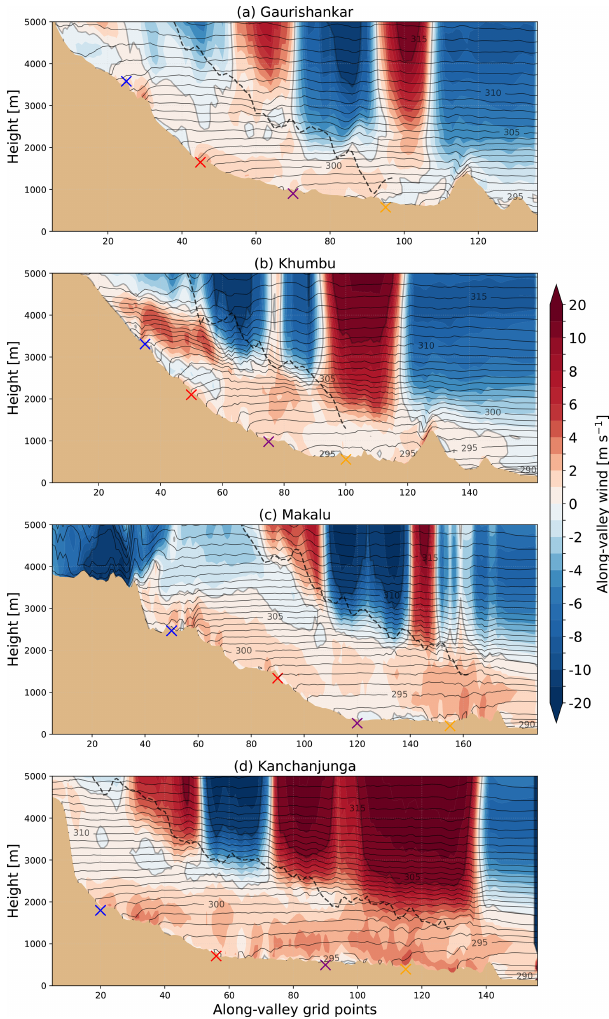
Figure 9. Vertical cross-section of potential temperature (grey con- tours) and the along-valley wind component (shading) above the valley centre lines (yellow lines in Fig. 2) on 20 December at 15:00LT. Potential temperature is plotted with a contour interval of 1K. Positive values for the along-valley wind refer to up-valley winds. The mean of the two ridge heights is shown by the black dashed